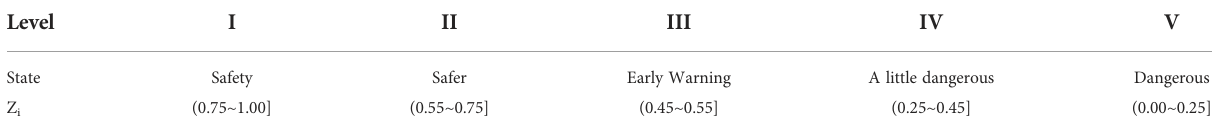
TABLE 5 Levels of coastal zone ecological security.